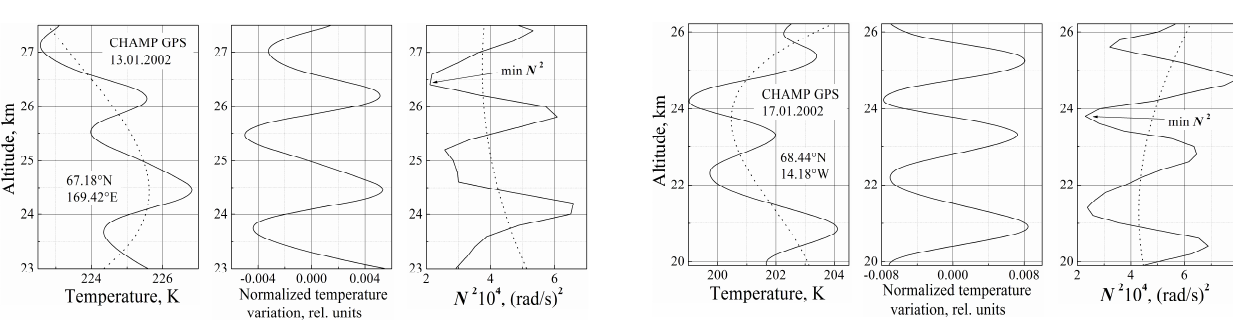
Fig. 2. The same as Fig. 1, except from radio occultation conducted Figure 2. The same as Fig. 1, except from radio occultation conducted in the high latitudes of in the high latitudes of the Earth’s atmosphere on 13 January 2002. the Earth’s atmosphere on 13 January 2002. 5